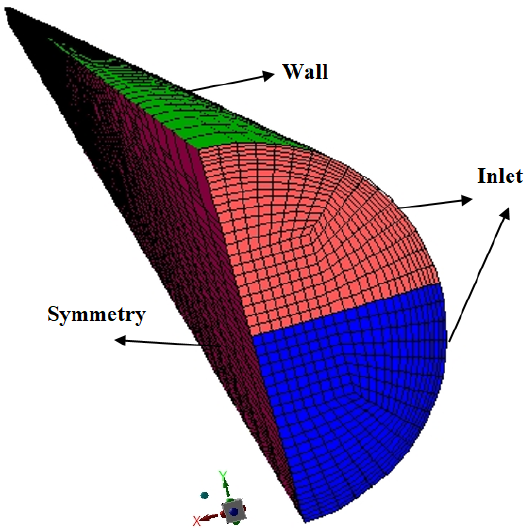
Figure 1. The computational grid and boundary conditions used in the CFD model.